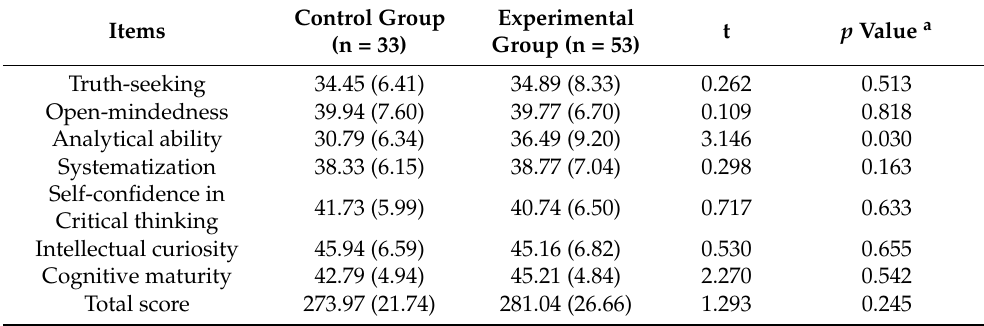
Table 3. Comparison of students’ critical-thinking ability between two groups at the end of the